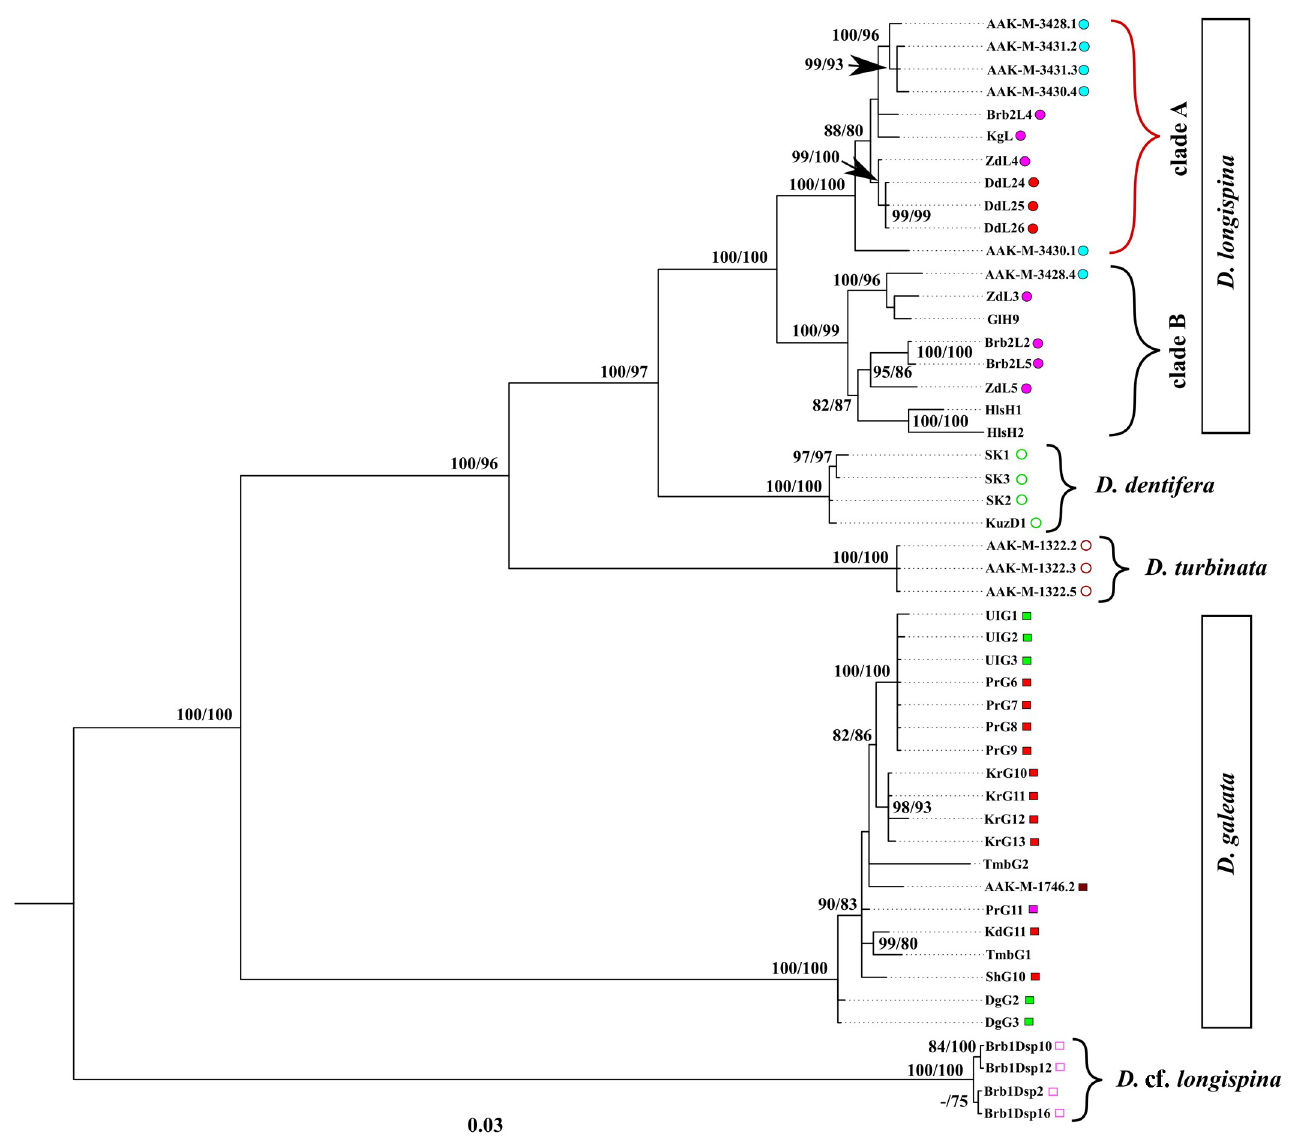
Fig 4. Bayesian phylogenetic consensus tree for D . longispina based on the concatenated ( 12S + 16S + ND2 ) dataset. Bayesian posterior probabilities BI and bootstrap values from ML analysis above 75% expressed as a percentage are indicated for each significant node. The scale is given in expected substitutions per site. Colored geometric symbols are the same as in Fig